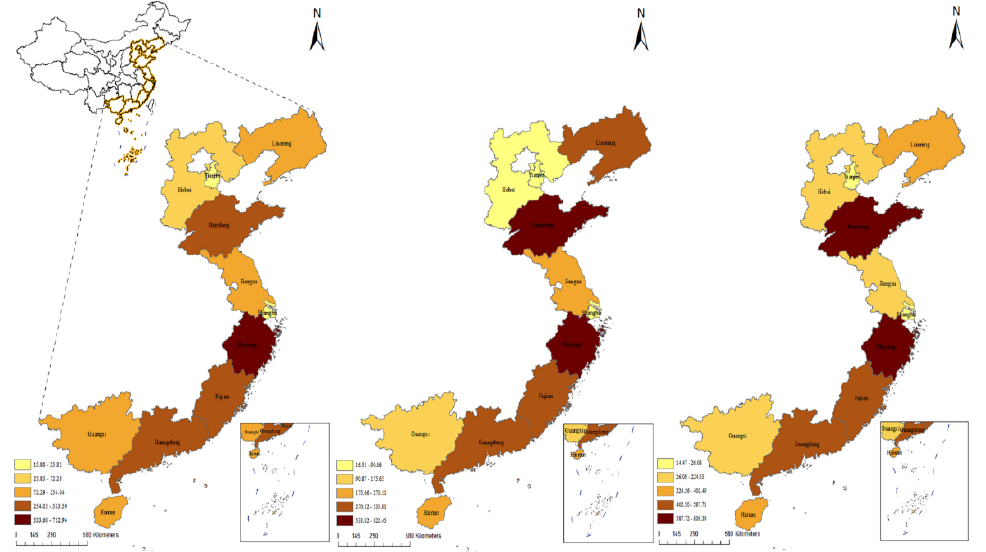
Figure 6. Spatial and temporal distribution of carbon emissions from marine fisheries in 11 coastal provinces of China; the graphs represent 2005 ( left ), 2012 ( middle ), and 2020 ( right ), respectively.